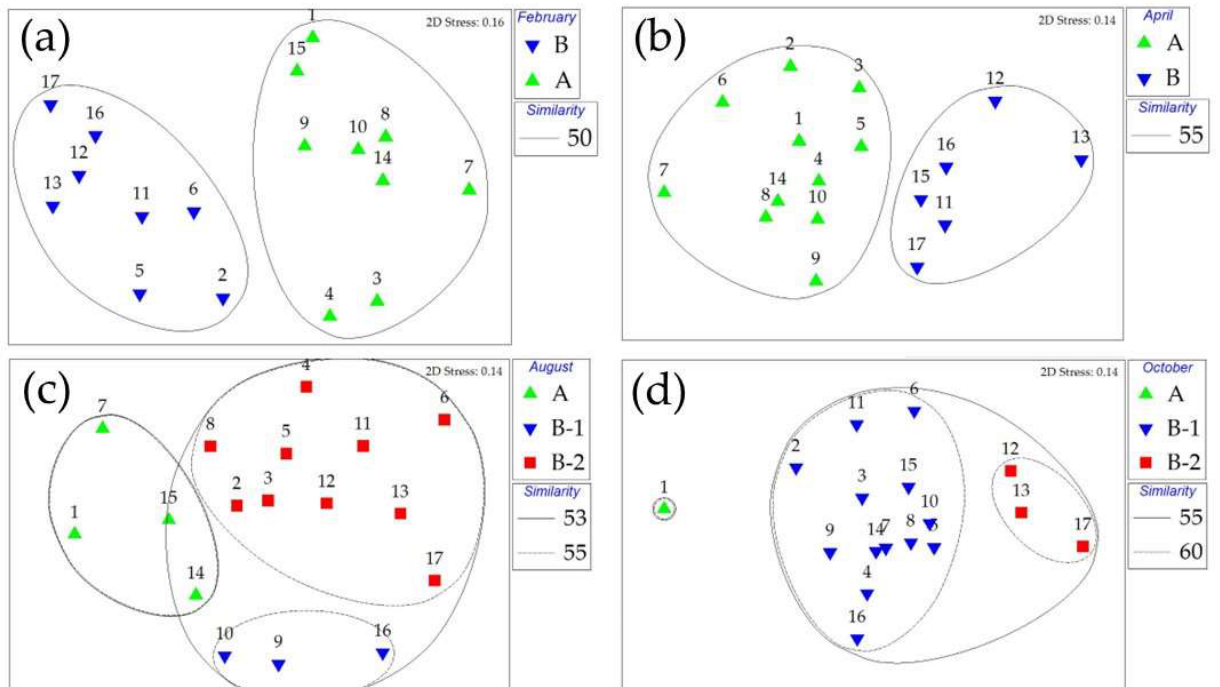
Figure 6. Dendrogram from the cluster analysis based on the Bray–Curtis similarities that were estimated using copepod abundance in the Korea South Sea and a non-metric multidimensional scaling (nMDS) analysis in ( a ) February, ( b ) April, ( c ) August, and ( d ) October 2018.